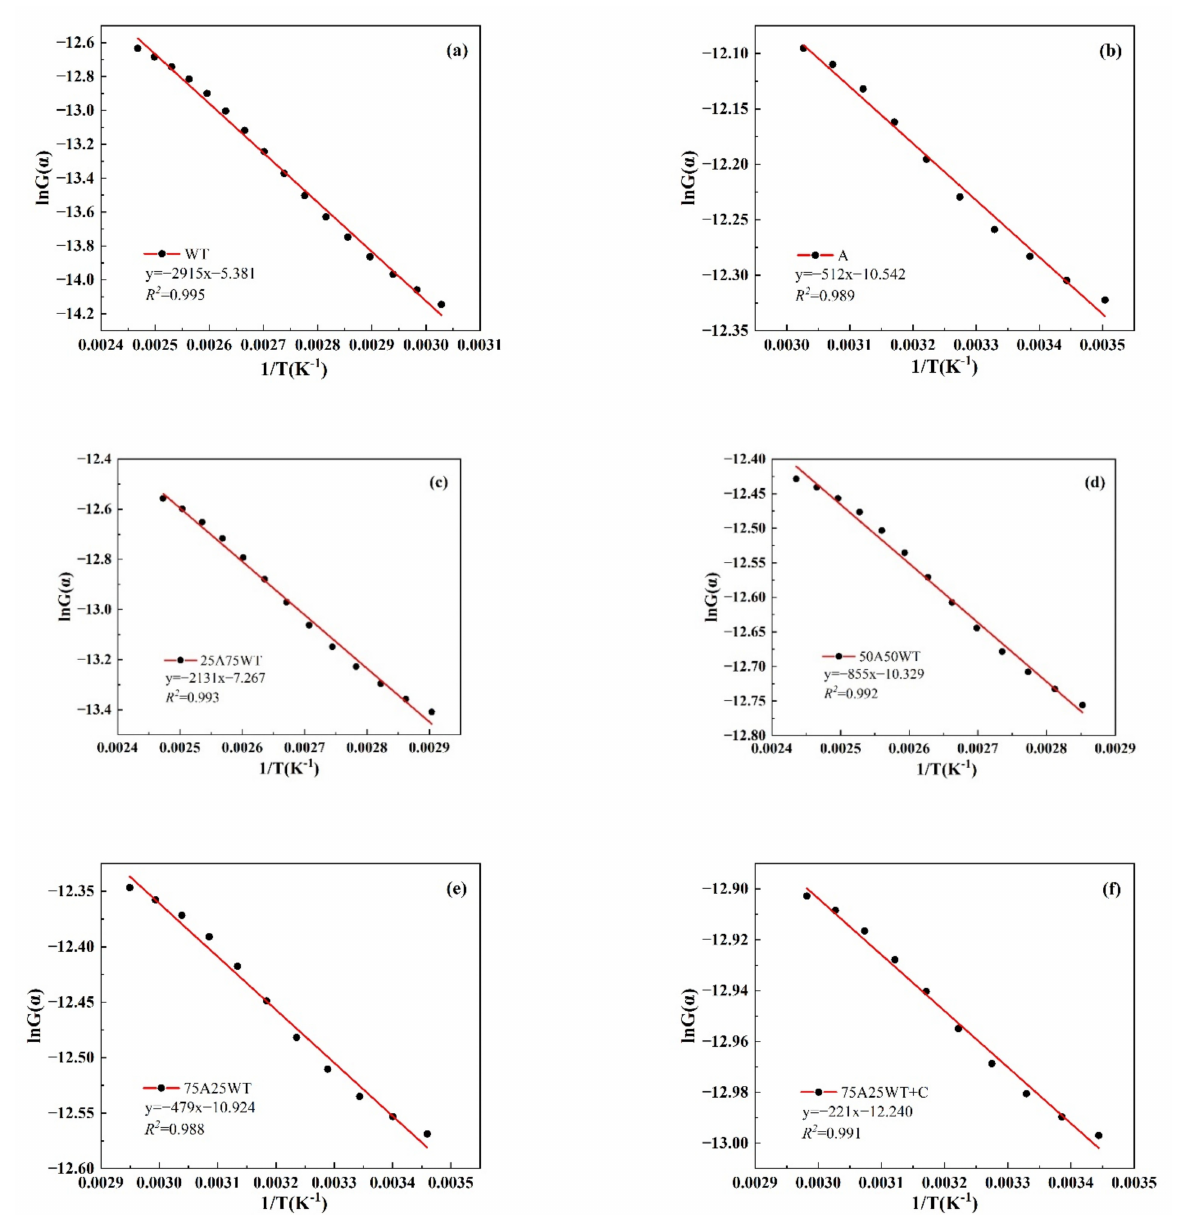
Figure 8. The slopes and intercepts of the samples of the plot ln(G( α )) vs.1/T for ( a ) WTS, ( b ) AP, and ( c – f ) their blends with and without